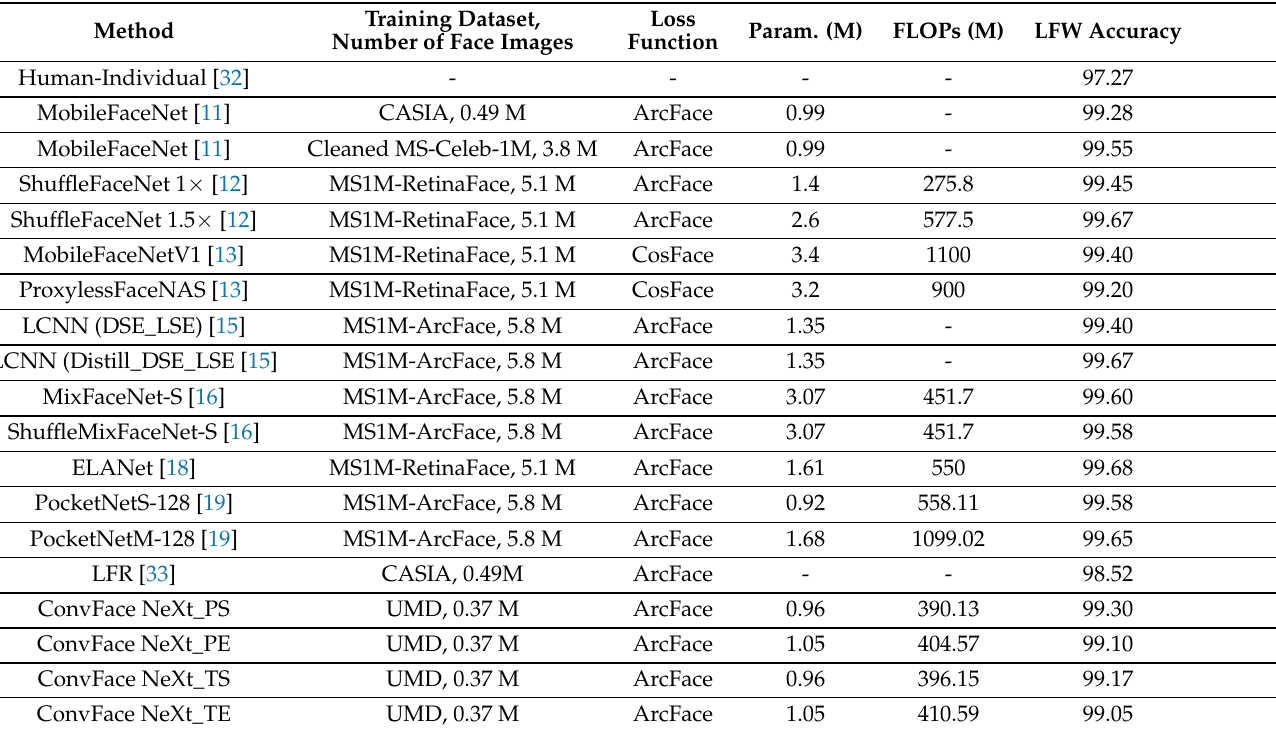
Table 12. Verification accuracy on LFW dataset, as published in the works of previous lightweight face recognition models. The stated accuracy was obtained from the respective published paper, whereby each model was trained with a different dataset and loss